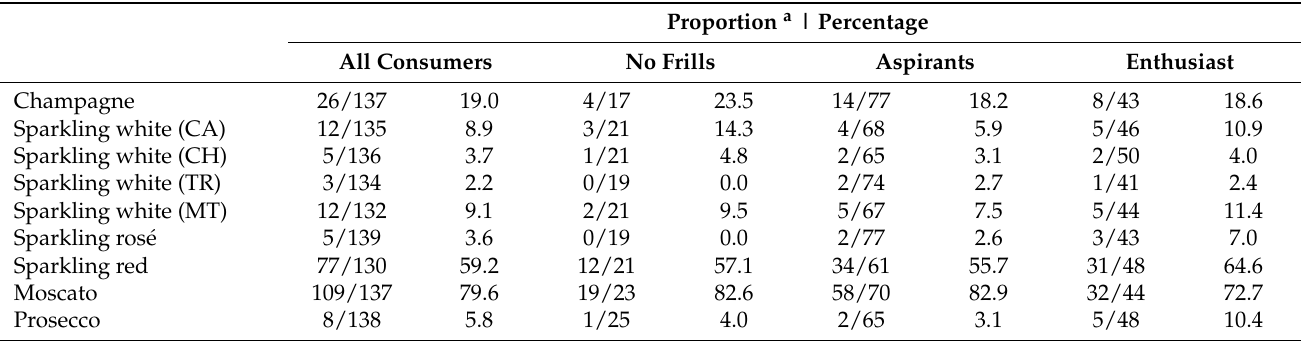
Table 7. Ability of consumers and Fine Wine Instrument consumer segments to correctly identify different sparkling wine styles (during blind